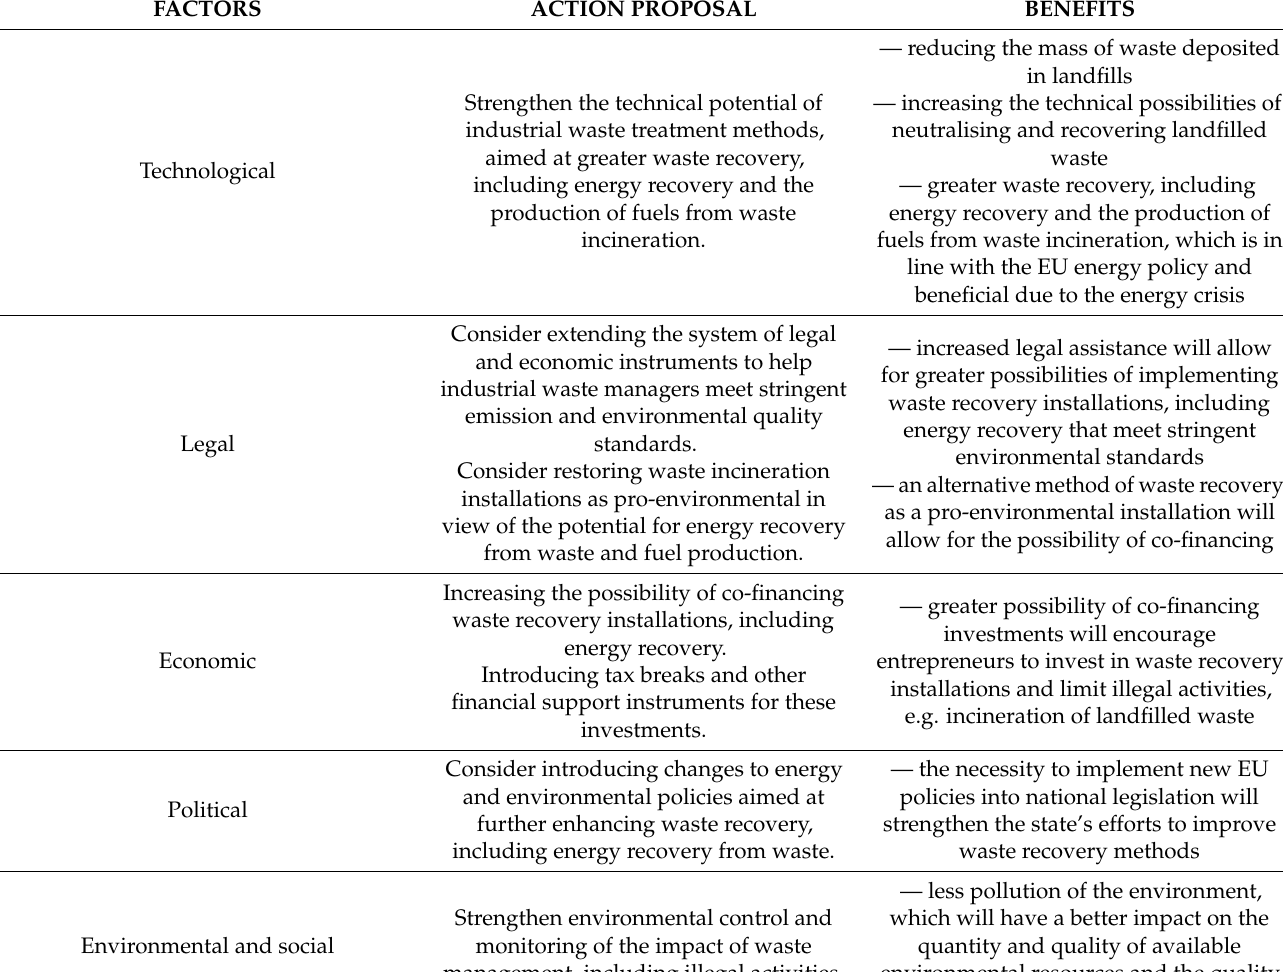
Table 9. Proposed industrial waste management strategy based on factor